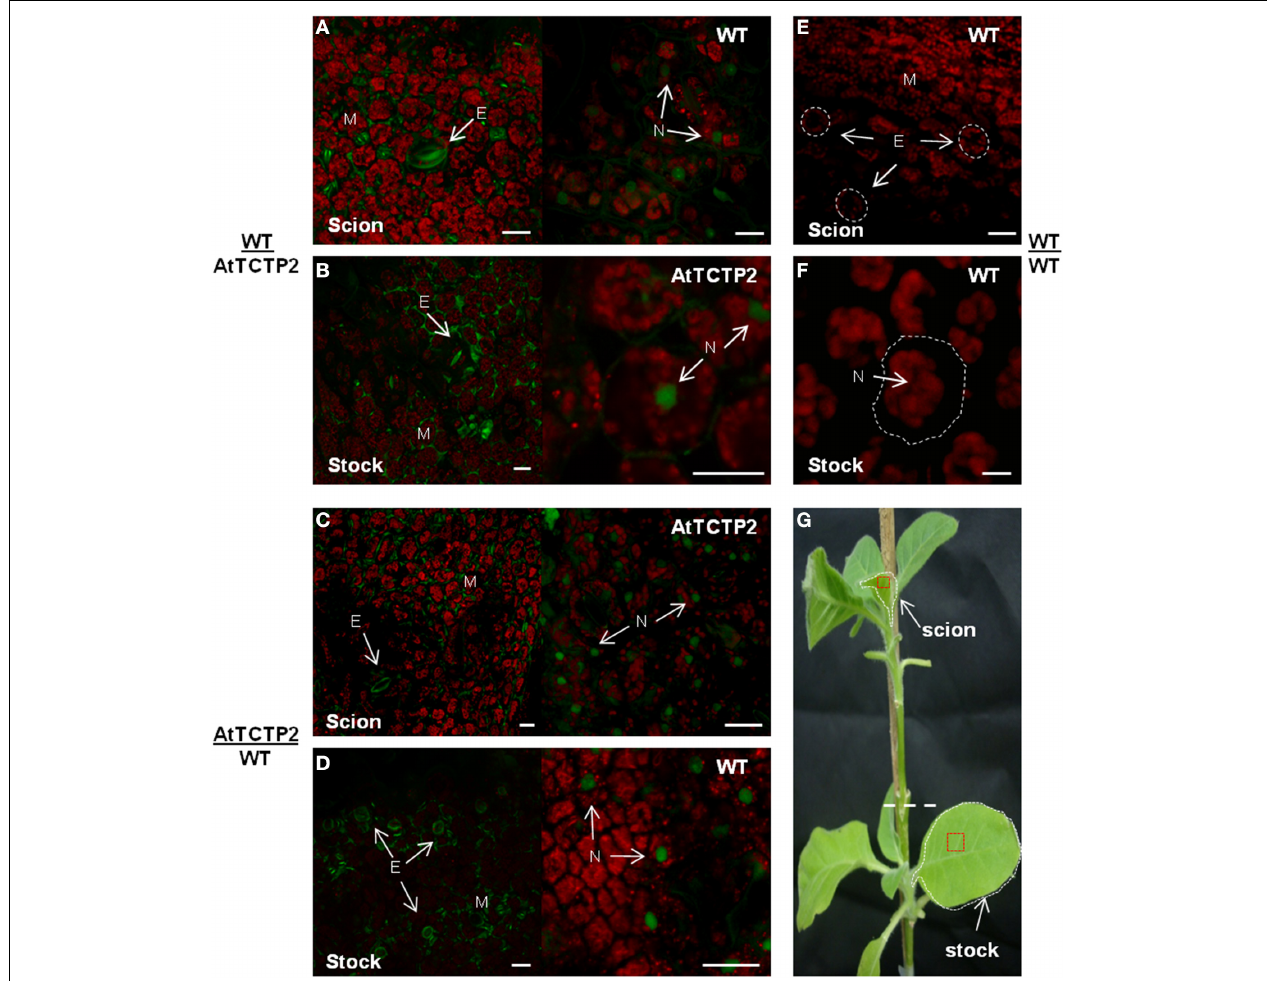
FIGURE 4 | AtTCTP2-GFP accumulation sites are conserved. Laser confocal microscopy was performed to detect the fluorescence associated to GFP fused to AtTCTP2 both in young-leaves near apical meristems (from scions) and in source well developed leaves (from stocks) for each graft tested. In WT/AtTCTP2 grafts the fusion protein AtTCTP2-GFP was identified in both (A) stock and (B) scion in all grafts (see Table 1 ) presenting the same localization pattern characterized by signal detection in stomata (S) and nuclei (N), besides mesophyll (M).